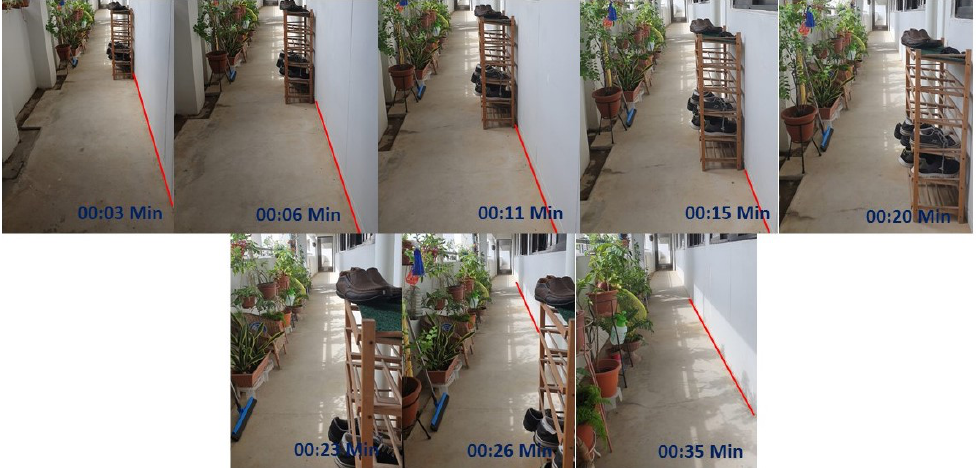
Figure 23. Series of image from the hsr robot during the trial with embedded time scenario